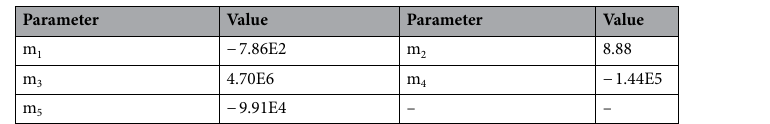
Table 1. Eq. (14) coefficient. Equation (14) is simple in calculation and can be used to calculate the horizontal displacement of soil caused by diaphragm excavation in related cases.